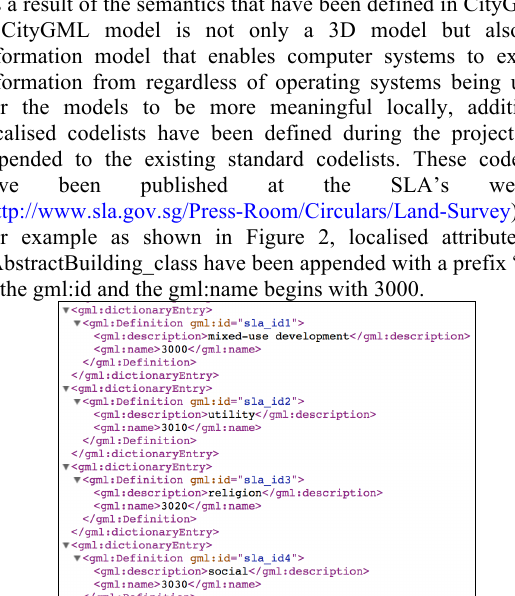
Figure 2. The localised codelist for _AbstractBuilding_class